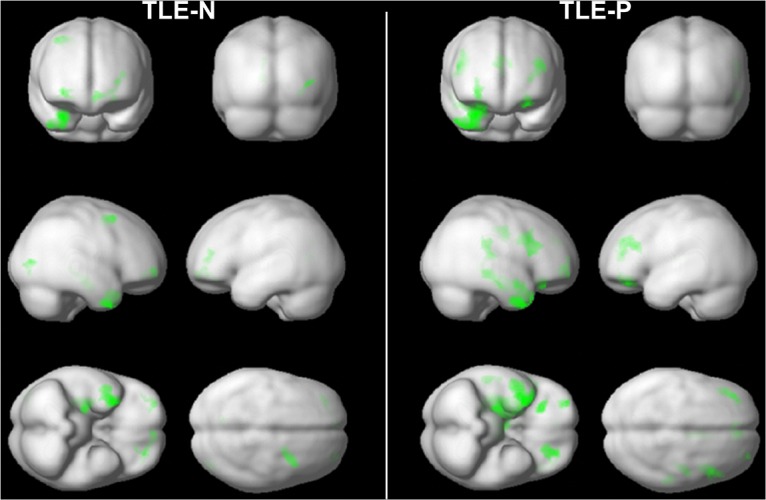
The results of morphological comparison of each TLE group with the healthy subjects.The right side of brain images is the focus side. Colored areas denote significant gray matter reduction: a height threshold of p<0.001 (uncorrected) and an extent threshold of p<0.05 (uncorrected).